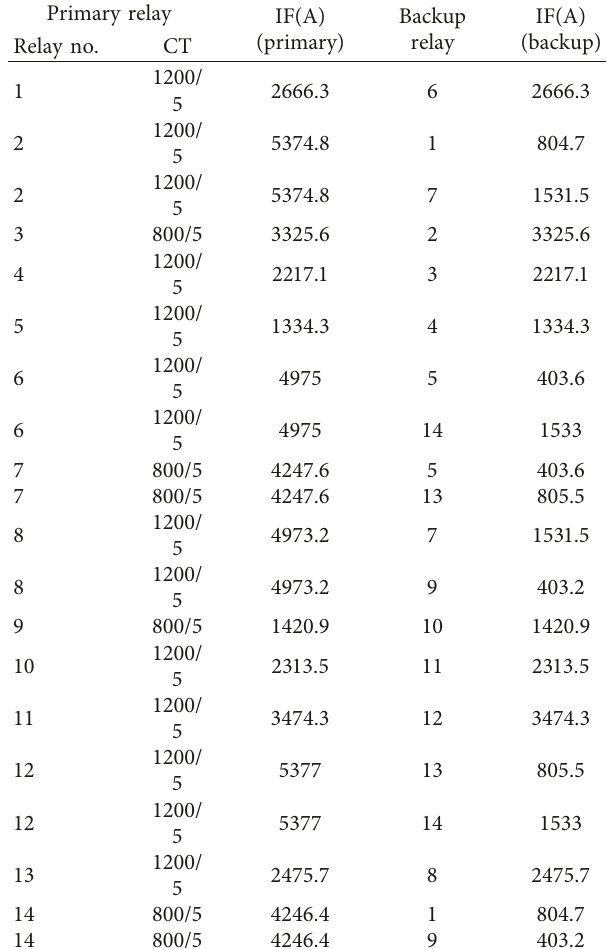
Table 8: P/B pairs and related parameters for the 8-bus system with NLP formulation